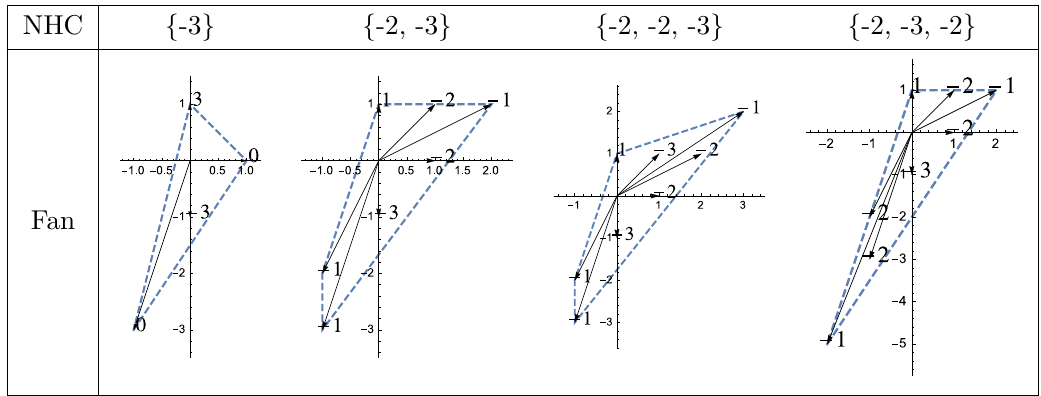
Table 6. Non-convexity of NHCs: the rays corresponding to an NHC cannot be a vertices; hence, the vertex contribution from the base can only come from curves of self-intersection (cid:21) (cid:0) 1 (isolated -2 curves will be on a 1D face, and also cannot be